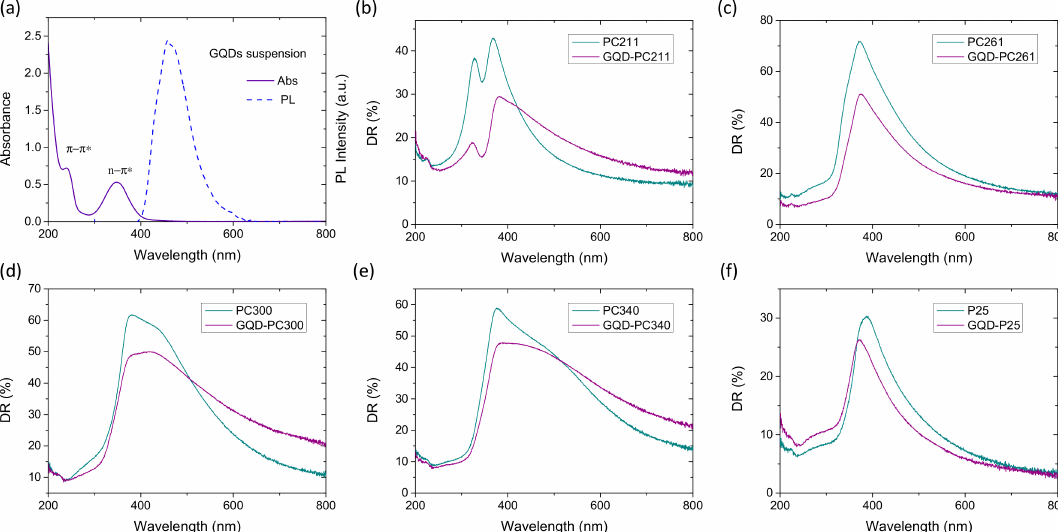
Figure 3. ( a ) Absorbance and photoluminescence (PL) of the graphene quantum dot (GQD) suspension (diluted to 0.025 mg / mL). Di ff use (DR%) reflectance spectra for ( b ) PC211, ( c ) PC261, ( d ) PC300, ( e ) PC340, and ( f ) P25 films before and after QGDs surface